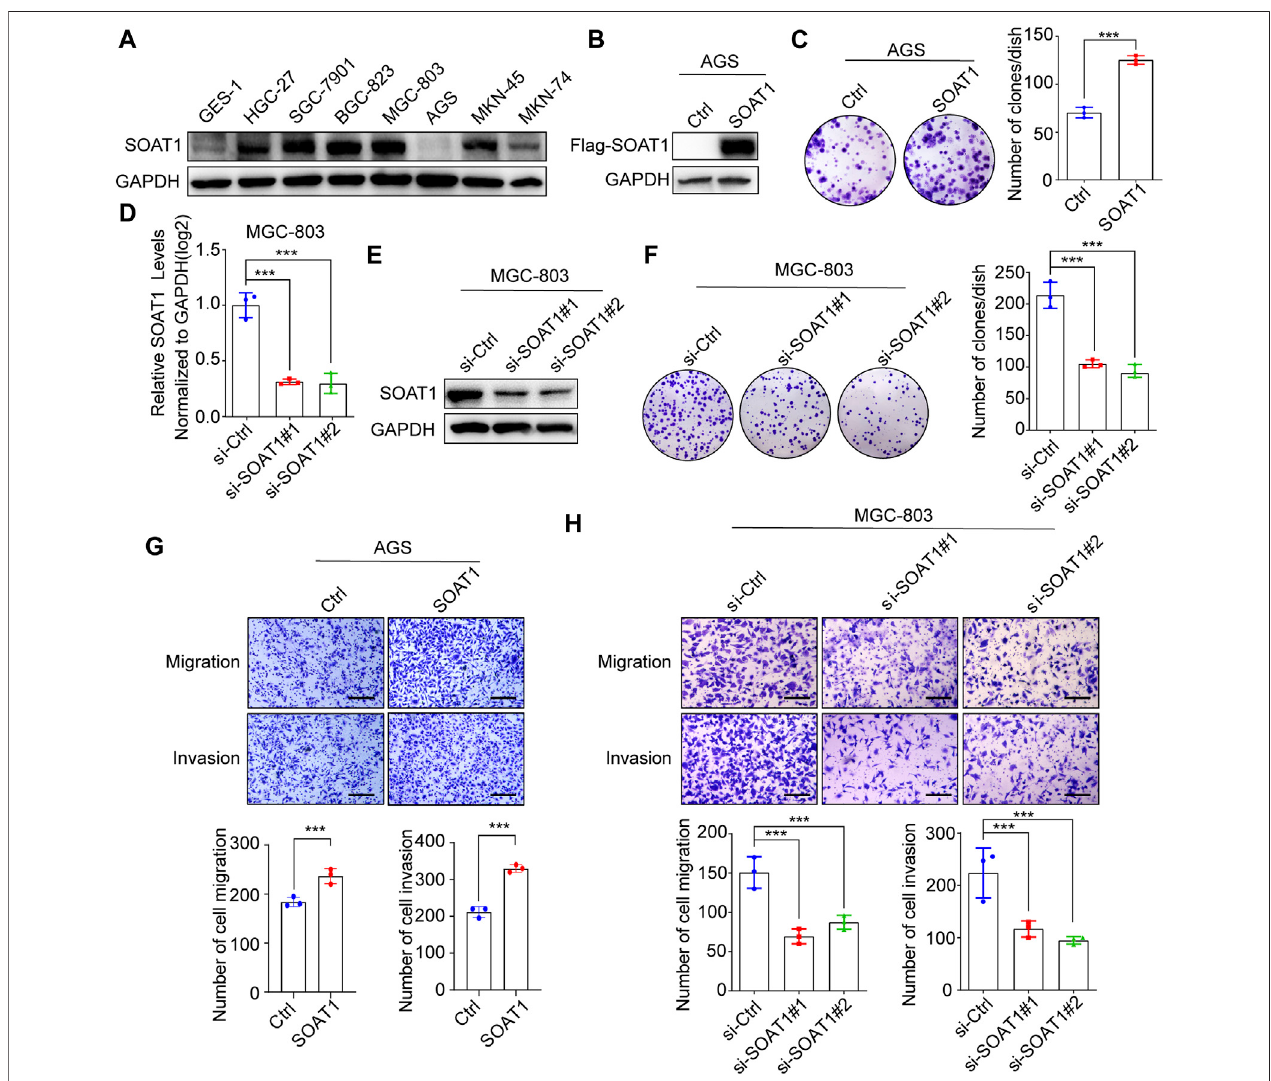
FIGURE3| SOAT1promotesGC cellproliferation,migrationandinvasion. (A) TheproteinlevelofSOAT1inGES-1cellsandGCcelllineswereanalyzedbywesternblot. (B) The overexpression ef fi ciencies were veri fi ed at the protein level in AGS by western blot. (C) Representative images of colony formation assay in AGS after overexpression of SOAT1(leftpanel), the right panel shows thequantitativeresults. (D,E) The knockdown ef fi ciency wasveri fi ed atthemRNAandprotein levels by qRT-PCR (D) and western blot assay (E) ,respectively. (F) RepresentativeimagesofcolonyformationassayinMGC-803afterknockdownofSOAT1(leftpanel),andthequantitativedatawereshown(right panel). (G) Transwell assays in SOAT1 overexpression AGS cells. Representative images of migrated and invaded GC cells in each group were shown in the upper panel, and quantitativeresultswereshowninthelowerpanel. (H) TranswellassayinMGC-803cellsafterknockdownofSOAT1.RepresentativeimagesofmigratedandinvadedGCcellsin each group were shown in the left panel, and the quantitative results were shown in the right panel. Scale bars: 100 µm.